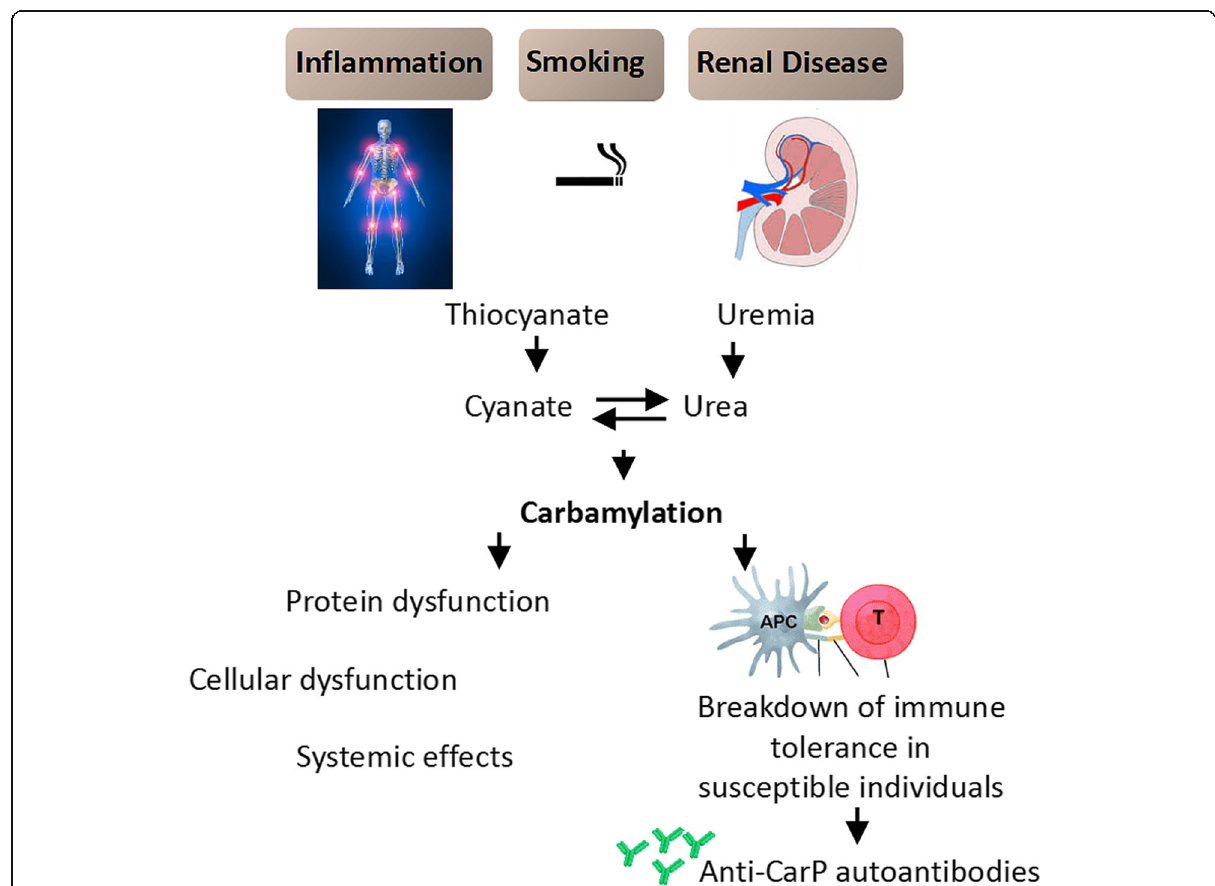
Fig. 5 Schematic representation of causes and consequences of carbamylation. Inflammation, smoking and renal disease may shift the balance towards predominance of cyanate over urea, allowing carbamylation. As a consequence of excess carbamylation, protein and cellular dysfunction may occur, leading to systemic effects. In susceptible individuals, extensive carbamylation will provide the trigger for the development an autoimmune response directed against carbamylated